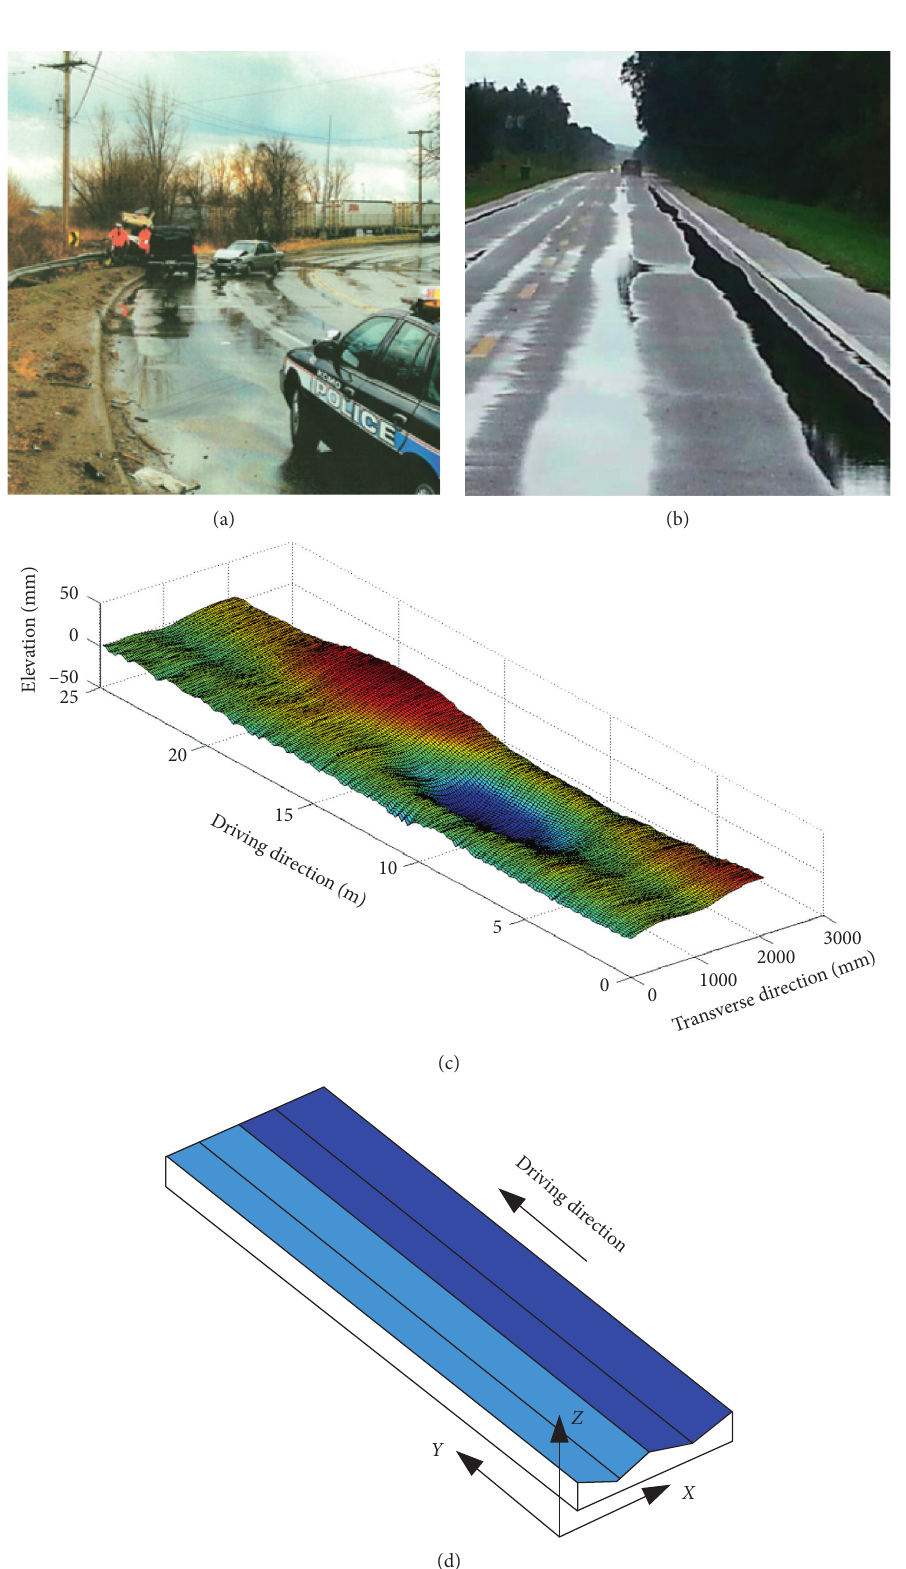
Figure 1: Uneven water-filled rut and existing water-filled rut depth model. (a) A traffic accident caused by water-filled ruts. (b) Asymmetric water-filled rut in the horizontal direction (FDOT [4]). (c) An uneven rut in both horizontal and longitudinal directions [5]. (d) The existing simplified rut depth model based on the maximum water depth of left and right